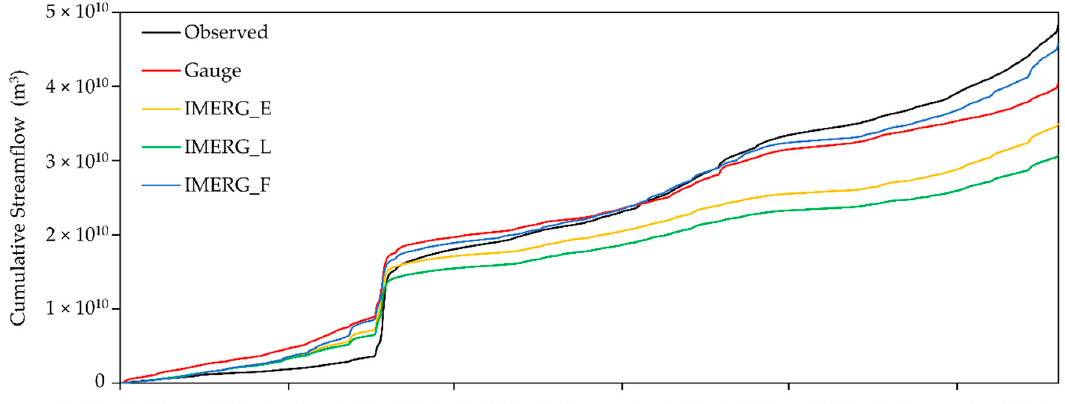
Figure 7. Comparison of cumulative streamflow simulated by the IMERG products and gauge at the